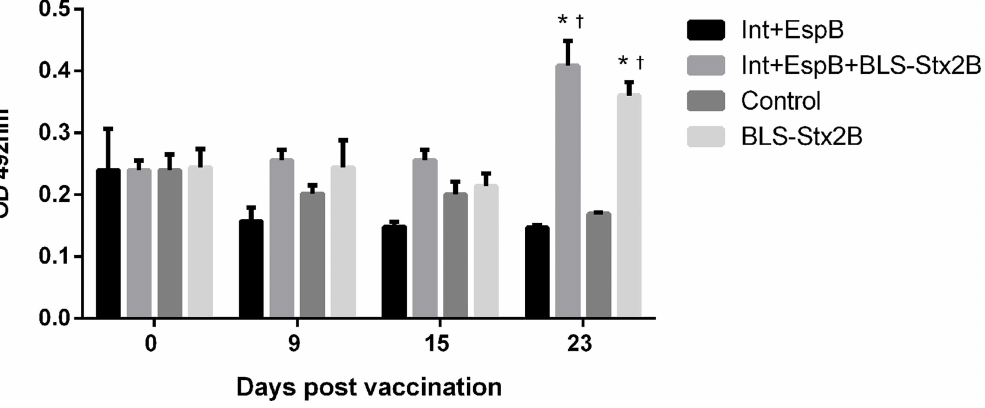
Fig 2. Immunoglobulin G responses to Stx2B in calves vaccinated with IntiminC 280 + EspB (2Ag); IntiminC 280 + EspB + BLS-Stx2B (3Ag); BLS-Stx2B and PBS (control) measuredby ELISA at different times post vaccination. Data are shown as OD492 ± standard error of the mean. * Indicates statistical significance (p < 0.05) comparedto the control and † indicatesstatistical significance comparedto the preimmune